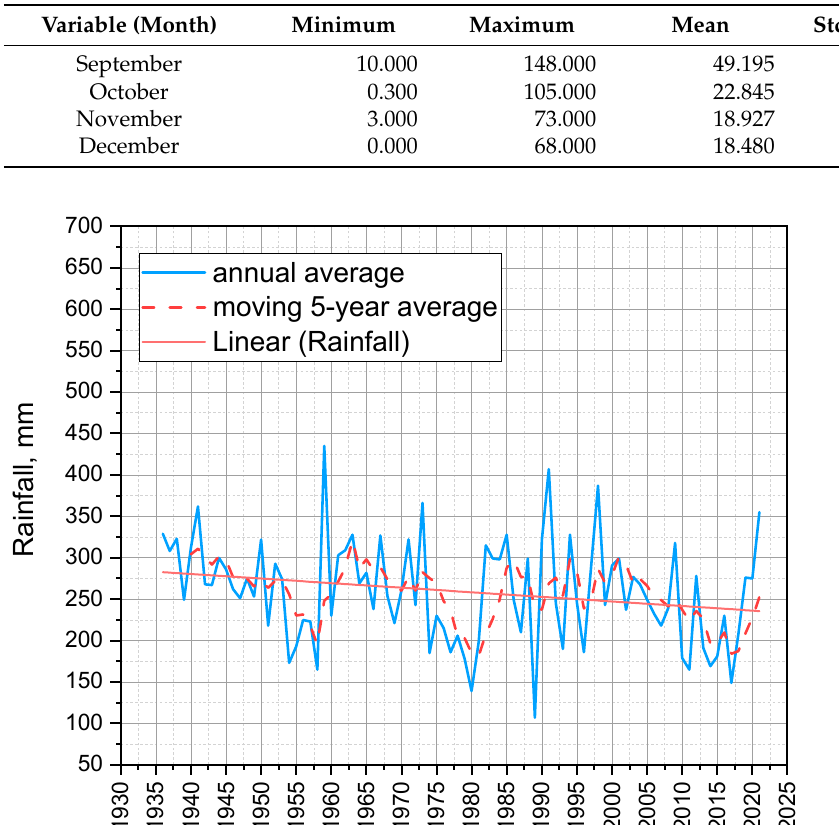
10 of 22 Table 6. SS and MK test results for the Ulan-Ude station. Variable (Month)